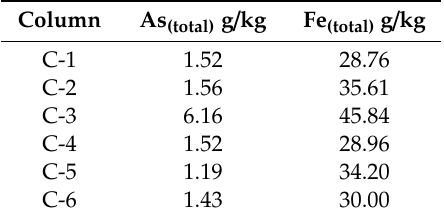
Table 6. Fe and As concentrations in the leaching residue.